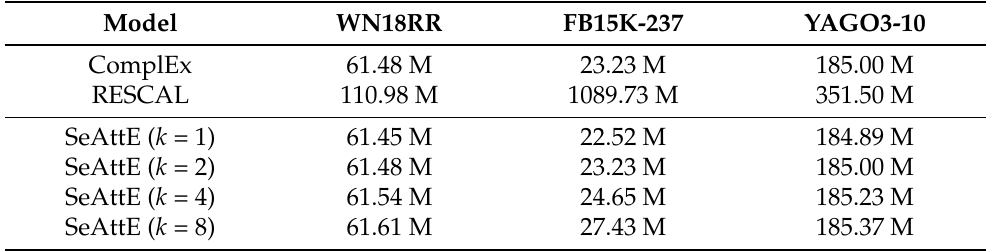
Table 5. This is the comparison of parameters between ComplEx, RESCAL and SeAttE, when entities have the same dimension ( d = 1500). k denotes the dimension of each attribute subspace in SeAttE.